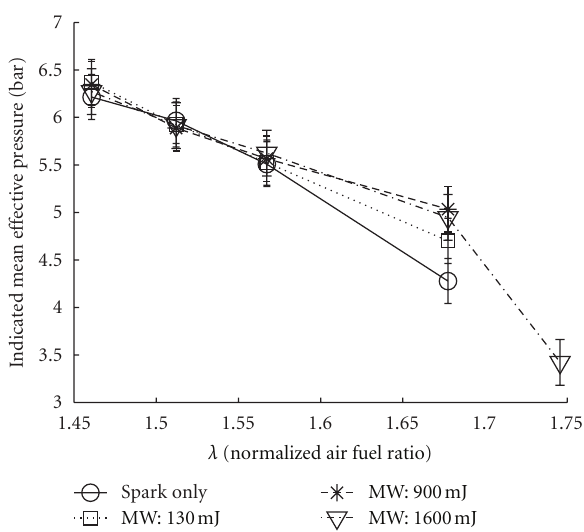
Figure 4: Addition of microwave energy slightly increased IMEP at larger λ . Increasing microwave energy did not further increase IMEP. Error bars are ± the uncertainty calculated using propagation of error (see Appendix A).